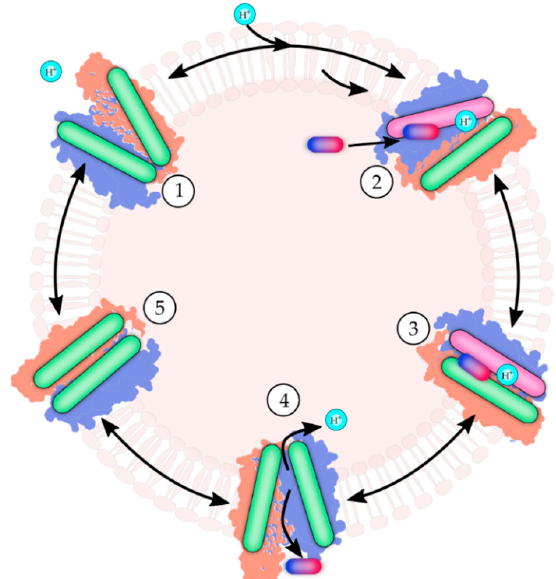
Figure 2. Ion-driven antiport mechanism of MFS multidrug efflux pumps. The oval cylinders rep- resent the two N- and C-terminal bundles, surrounded by shaded purple and brown space-filling three-dimensional structures. Protons are denoted as encircled H + . The pink cylinder represents an enhanced affinity for the proton. The multicolored capsules depict antimicrobial agents. The mech- anism described is based on studies summarized in references [62,63]. Steps 1–5 depict the follow- ing. 1: Outward open configuration of an empty MFS efflux pump. 2: The binding of H + ion on the outside increases the drug binding affinity inside in an inward occluded state. 3: Intermediate oc- cluded state. 4: Movement of the drug across the membrane to the outside and the H + ion inside the bacterial cell. 5: Intermediate empty occluded state.